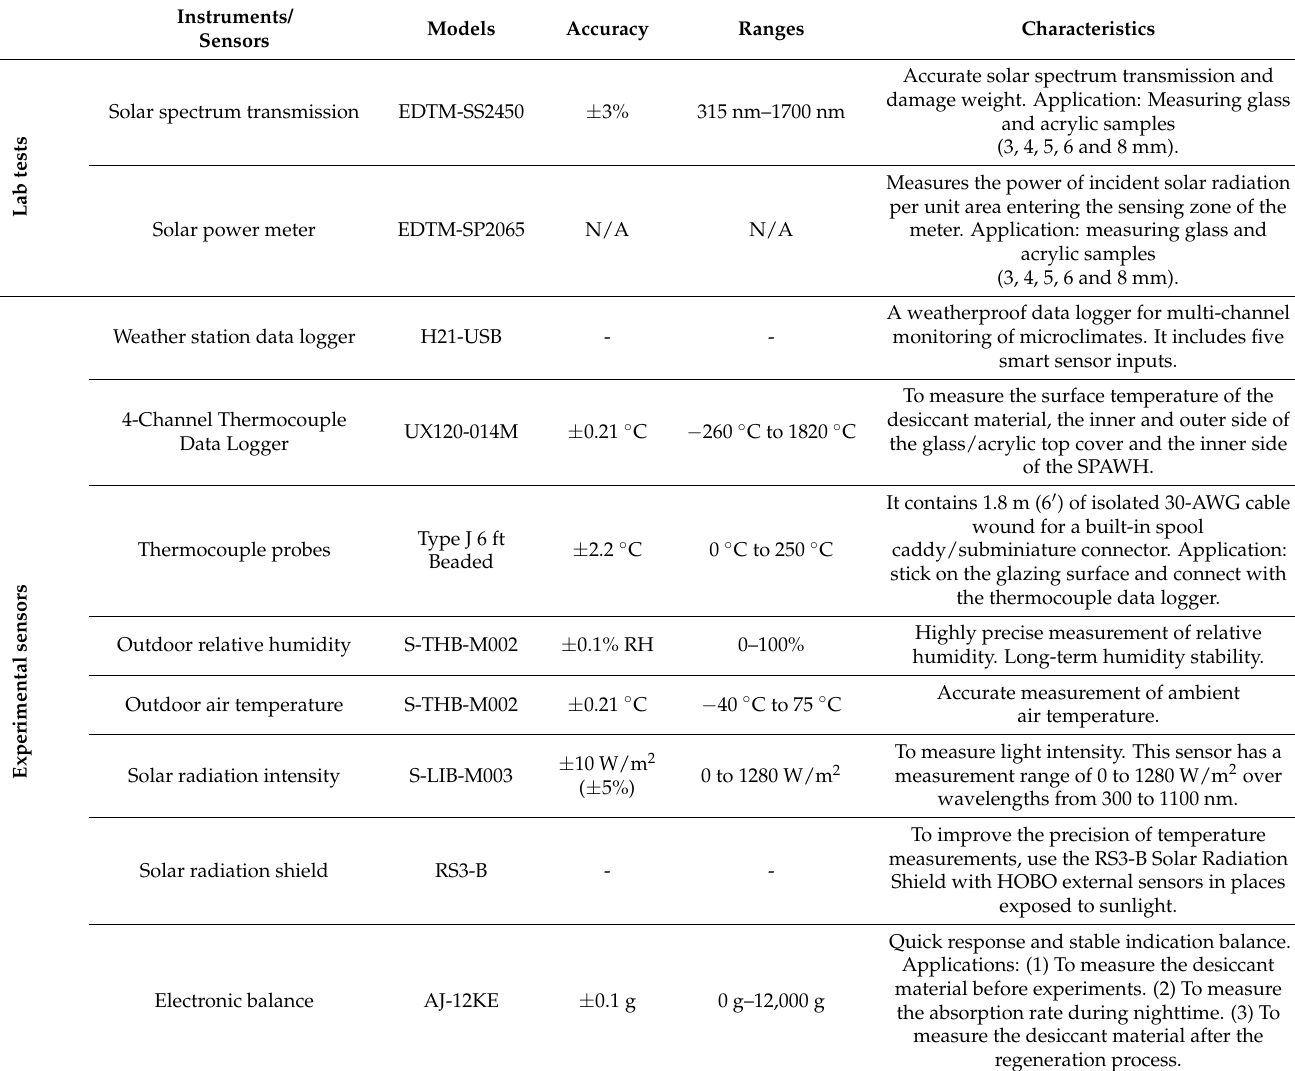
Table 4. Specifications of measuring instruments and